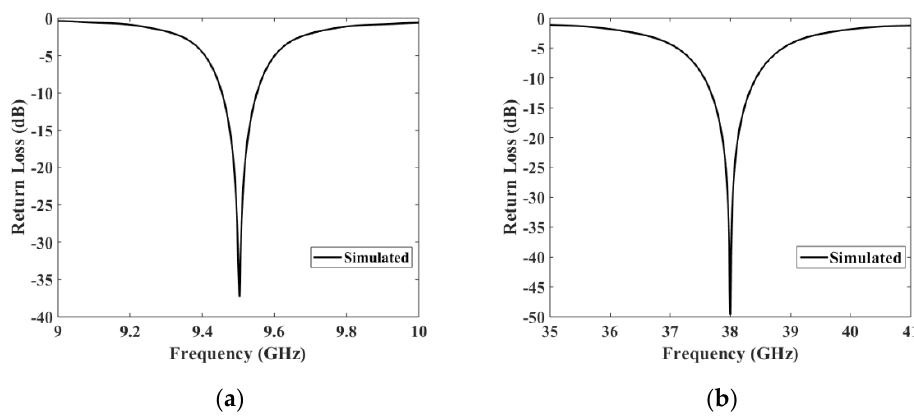
Figure 6. Return losses simulated for ( a ) S 11 at 9.5 GHz and ( b ) S 11 at 38 GHz.